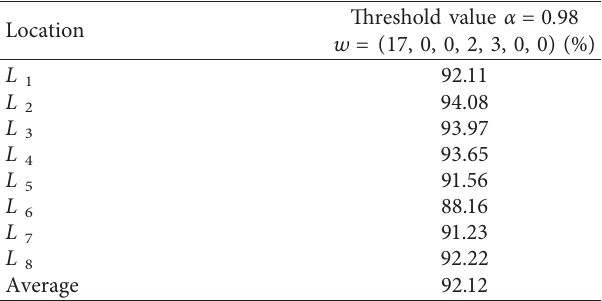
Table 11: The optimum average accuracy ratio of the haze warning system based on Algorithm